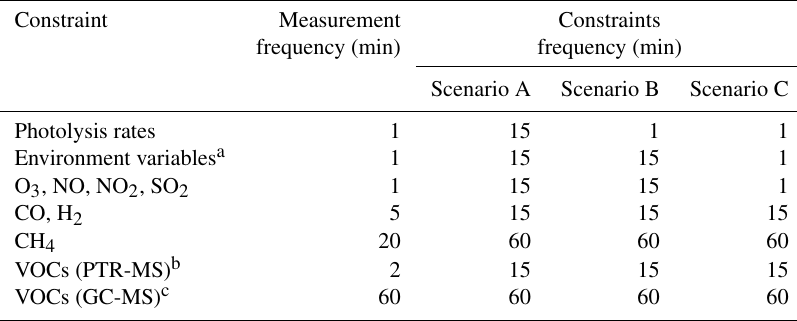
Table 1. Frequencies of the original measurements and averaged frequencies of the constrained data used in each model scenario. Constraint Measurement Constraints frequency (min) frequency (min) Scenario A Scenario B Scenario C Photolysis rates 1 15 1 Environment variables a O 3 , NO, NO 2 , SO 2